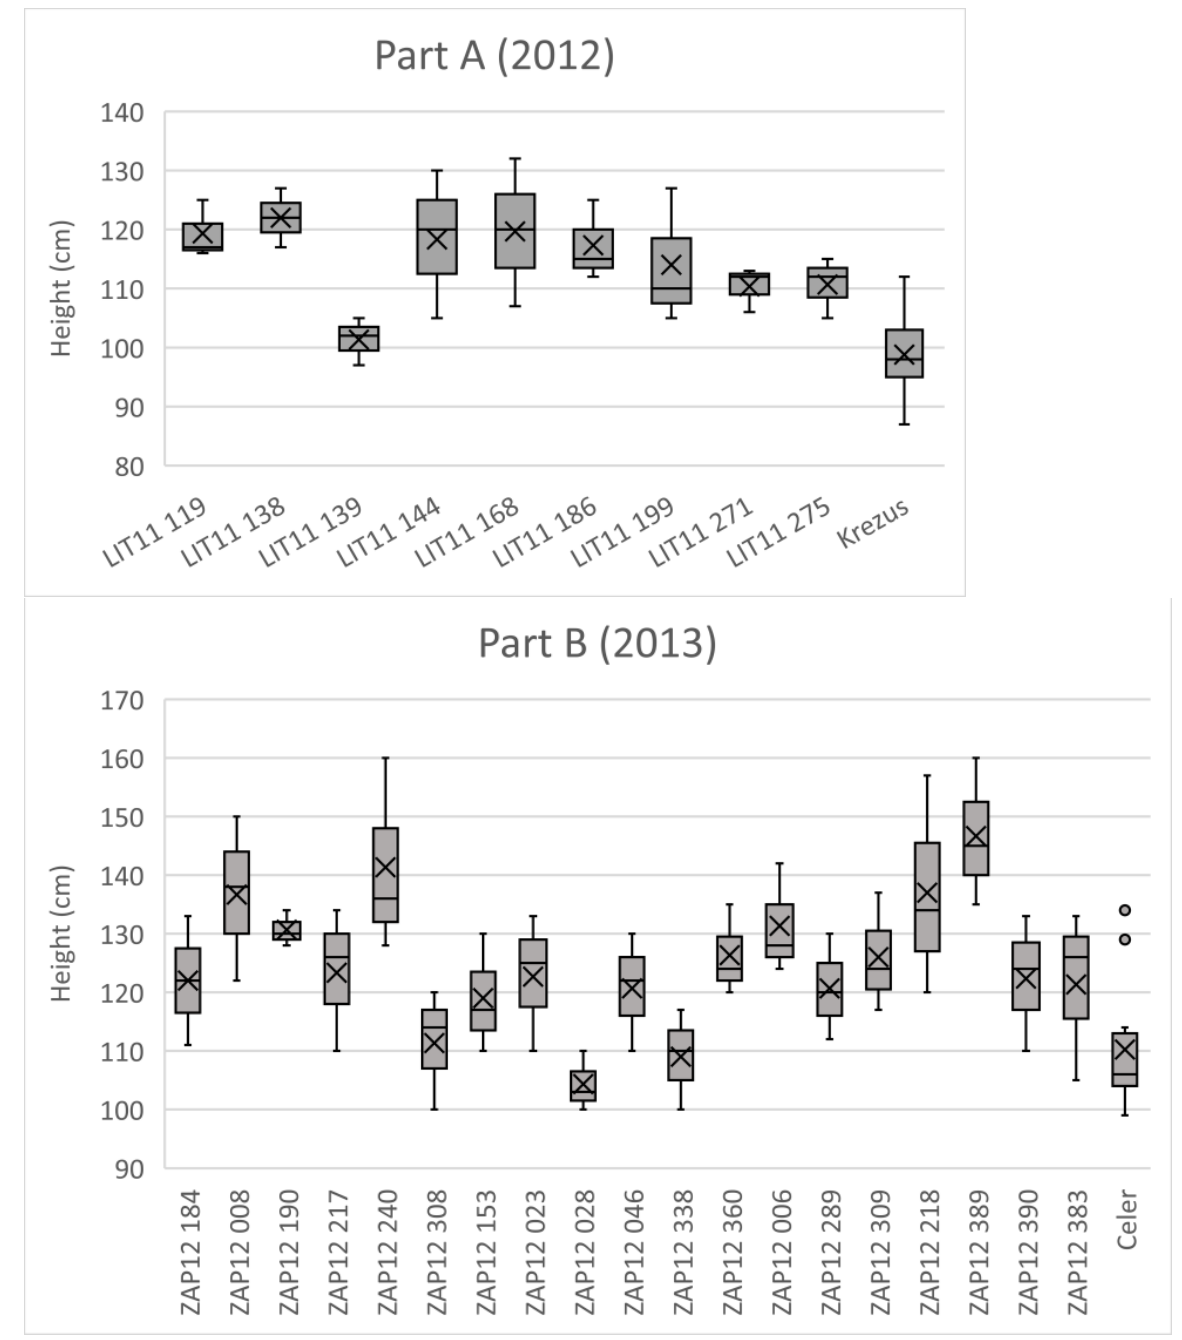
Figure 4. Variation in height of oat landraces gathered in Lithuania in 2012.